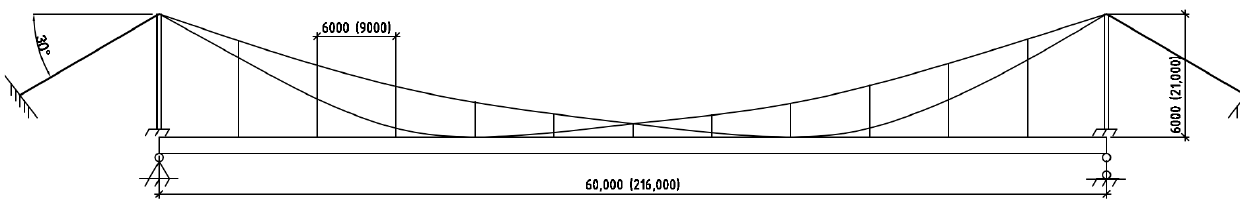
Figure 1. General layout of the bridges with a length of 60 m and a length of 216 m (the dimensions are shown in parentheses).